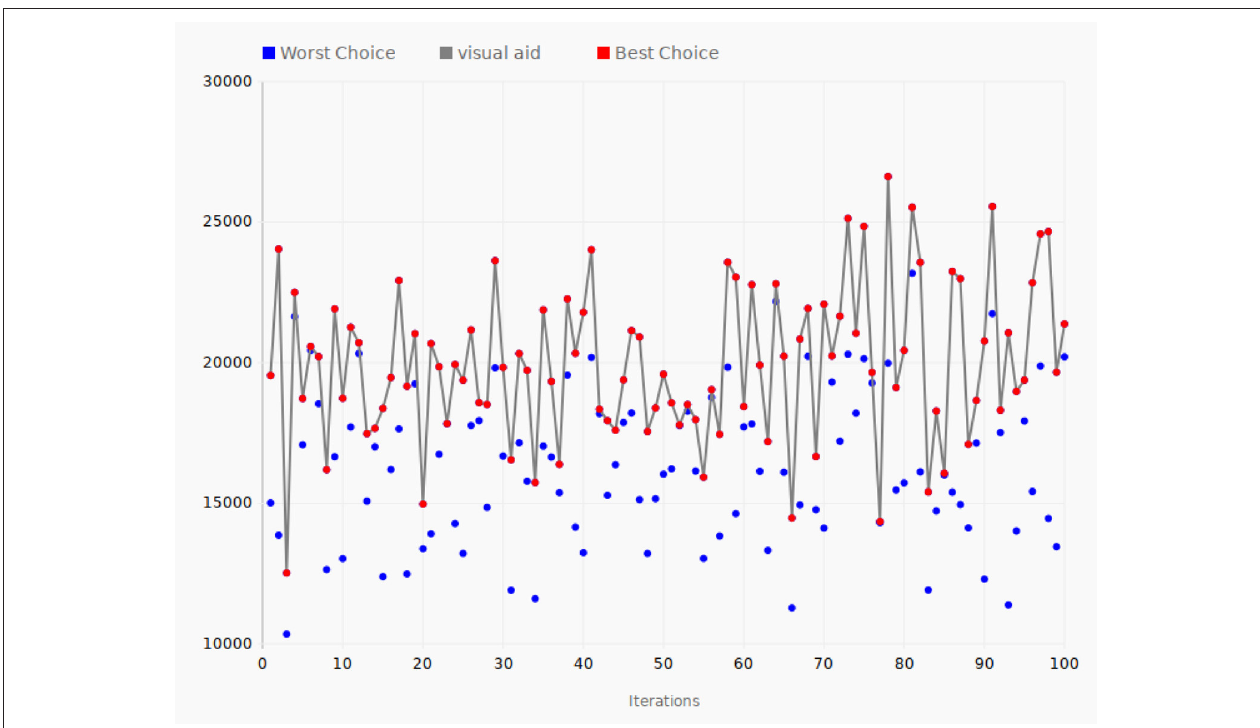
FIGURE 6 | Tuning iterations—taxi rides data. The gray line connects the best choices that give the largest value of the objective function for each of the 100 iterations.